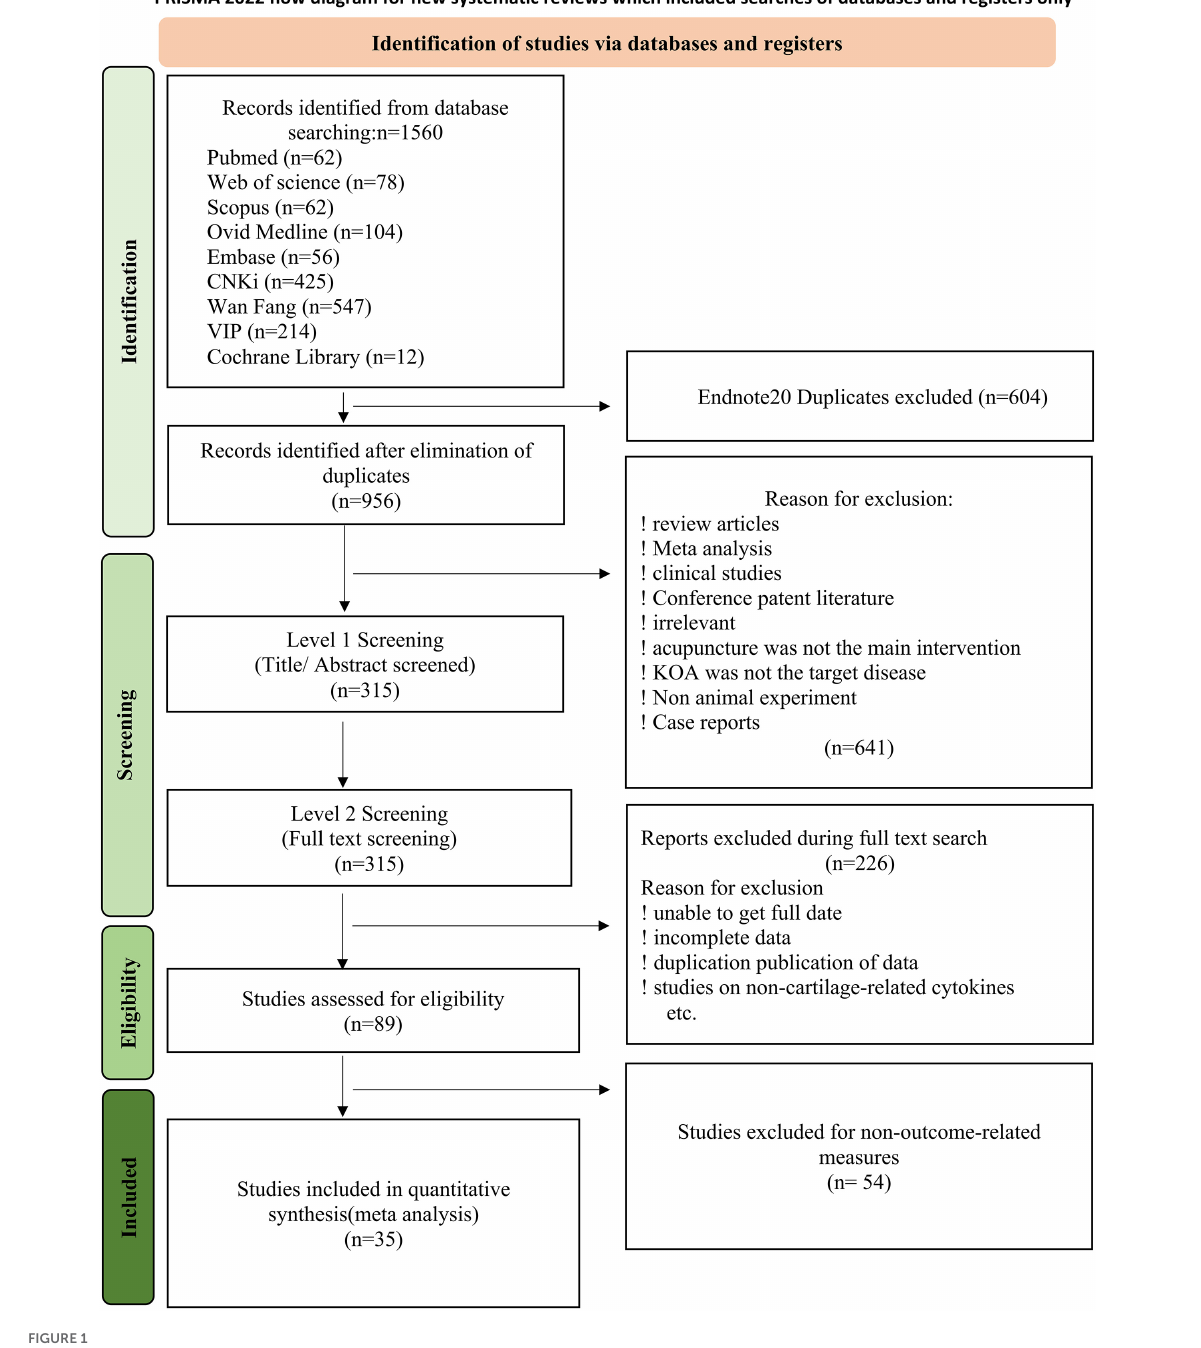
FIGURE1 Flow diagram of study selection